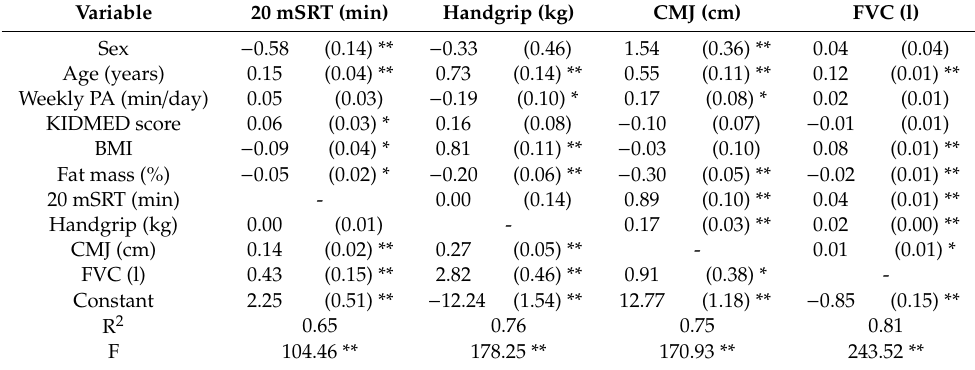
Table 2. Relationship of KIDMED score and physical fitness parameters (standard errors between